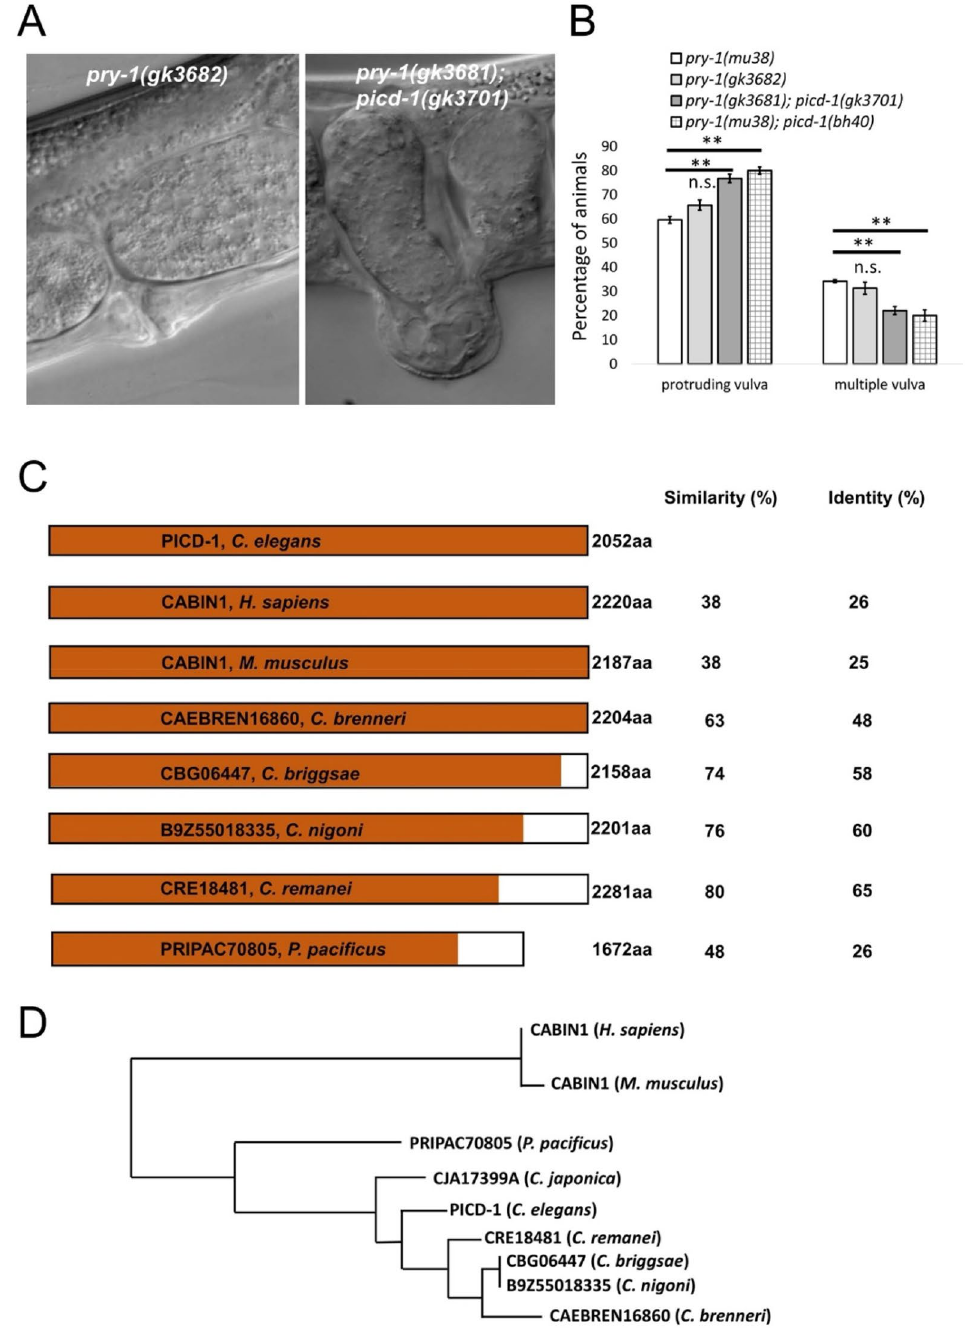
Figure 1. Phenotype of picd-1 mutants and sequence similarity of PICD-1 with CABIN1 proteins. ( A ) Representative images of Pvl phenotype in pry-1(gk3682) and pry-1(gk3681); picd-1(gk3701) animals. ( B ) picd-1 mutation enhances Pvl phenotype of pry-1 mutants. Data represent a cumulative of two replicates (n = 99 for pry-1(mu38), 160 for pry-1(mu38); picd-1(bh40) , 118 for pry-1(gk3682) and 156 for pry-1(gk3682); picd- 1(gk3701) ) and error bars represent the standard deviation (Also see Table 1 and Fig. 3). Statistical analyses for panel ( B ) were done compared to pry-1 mutants alone using one-way ANOVA with Dunnett’s post hoc test and significant differences are indicated by stars (*): ** ( p < 0.01). n.s., not significant. ( C ) Sequence comparison of C. elegans PICD-1 with mammalian CABIN1 and nematode homologs. Orange colors indicate regions of the proteins where alignments were identified by NCBI BLAST along with similarity and identity scores. Non-colored regions are those without sequence similarity. ( D ) Sequence alignment dendrogram generated by LIRMM (http:// www. phylo geny. fr/ simple_ phylo geny. cgi) using default